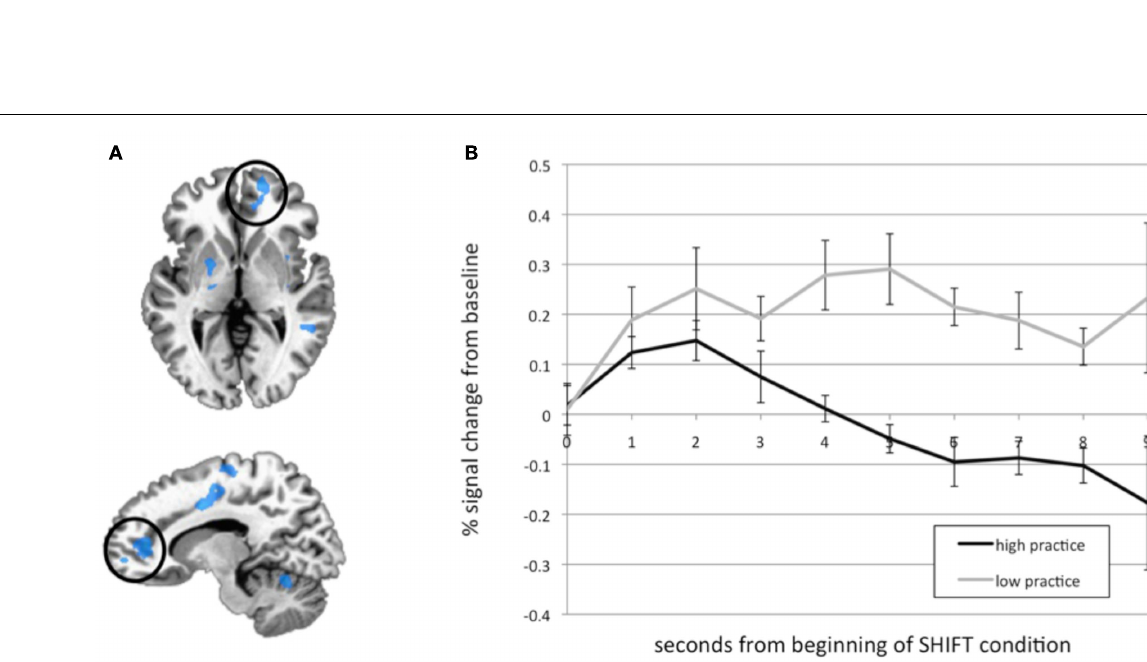
FIGUREA4 | Practice time effects. (A) Several clusters that were negatively correlated with practice time during the SHIFT phase.The medial PFC/ACC cluster that was examined in B is circled. (B) Time courses from the medial PFC/ACC cluster were extracted, and HRFs were calculated from the onset of the SHIFT phase for each subject. Percent signal change (from MW,